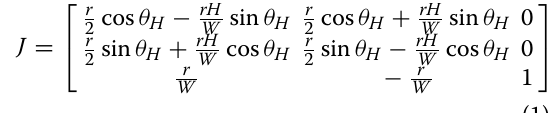
Fig. 17 Manipulation dataflow diagram